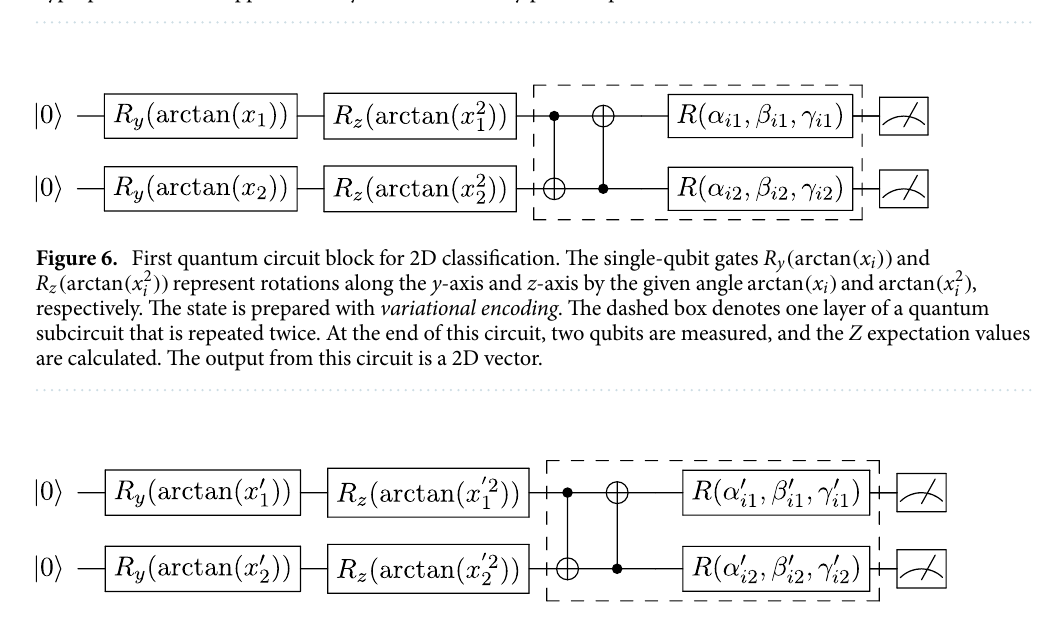
Figure 7. Second quantum circuit block for 2D classification. The parameters labeled R y ( arctan ( x ′ i )) and